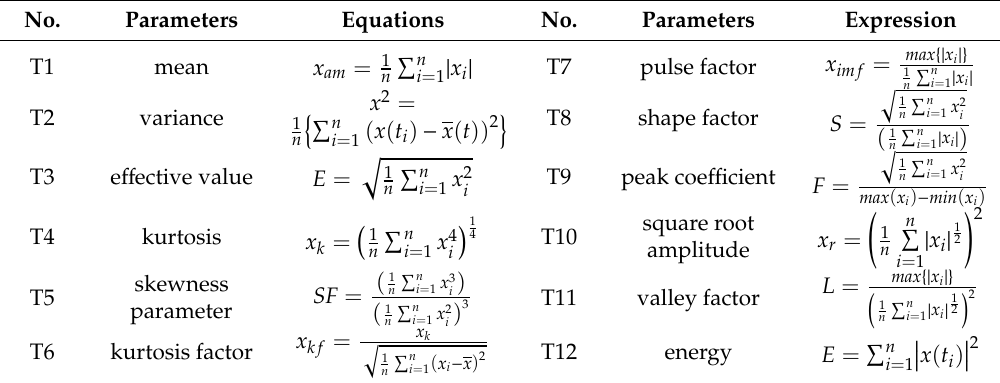
Table 1. The equations of features in the time domain and waveform